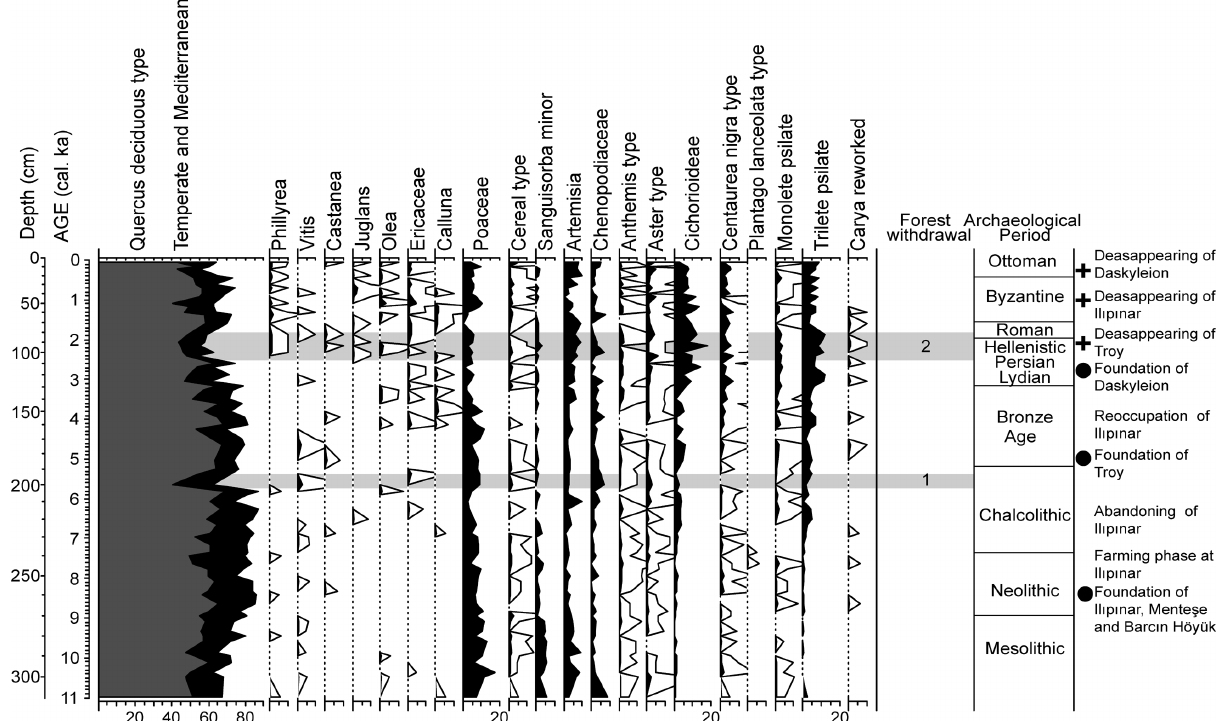
Fig. 6. Pollen percentage diagram showing selected taxa for core MD01-2430. Filled black curves show the percentage values of single pollen type; white curves indicate percentages enlarged by ten. Gray bands indicate phases of forest withdrawal for anomalies above 20%. Archaeological periods and most important events in the past societies for northern Anatolia region are shown on the far right, with circles indicating foundation of settlement(s) and crosses indicating their